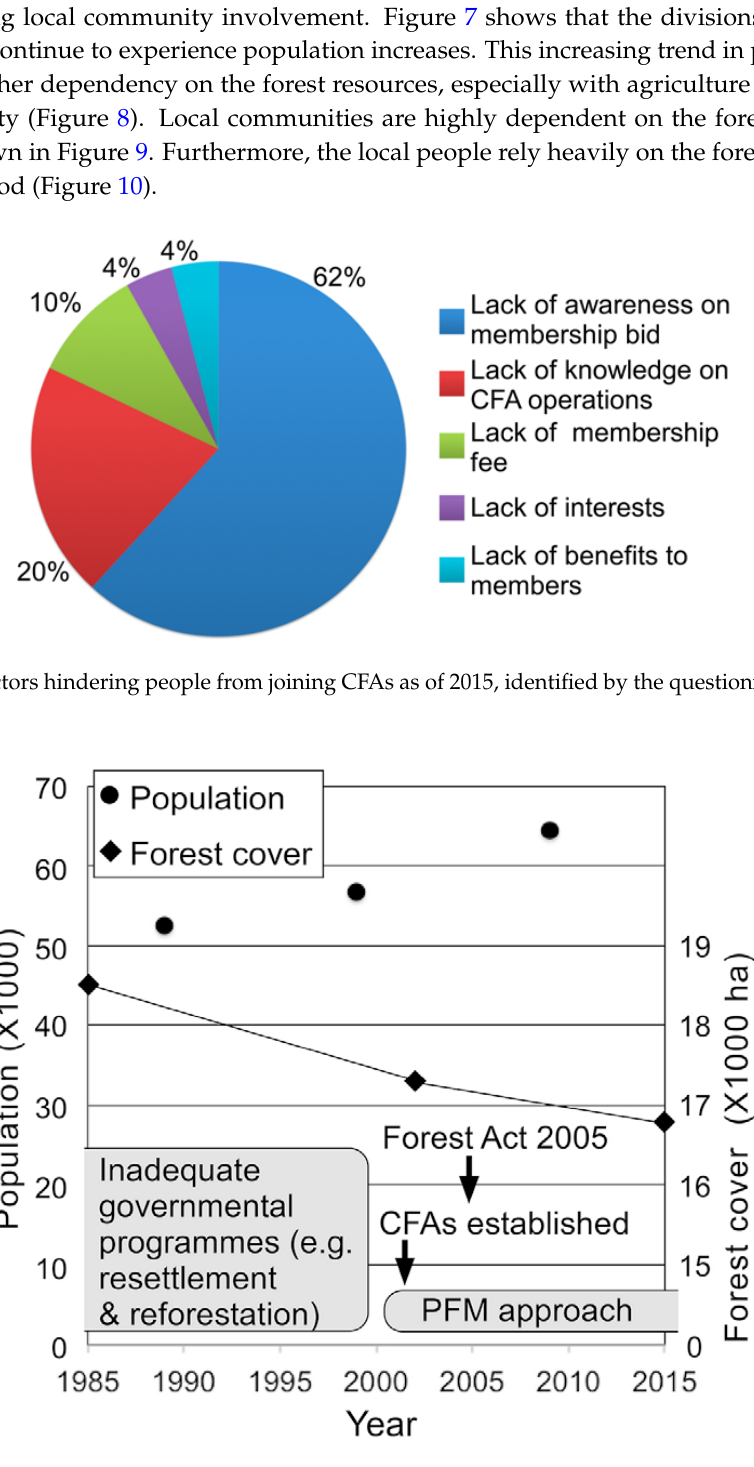
Figure 7. Relationship between the change of forest-cover decline rates and some important driving factors. Population data of the Torongo, Maji-Mazuri, Mumberes, and Eldama-Ravine divisions were supplied by the KNBS. PFM: participatory forest management.